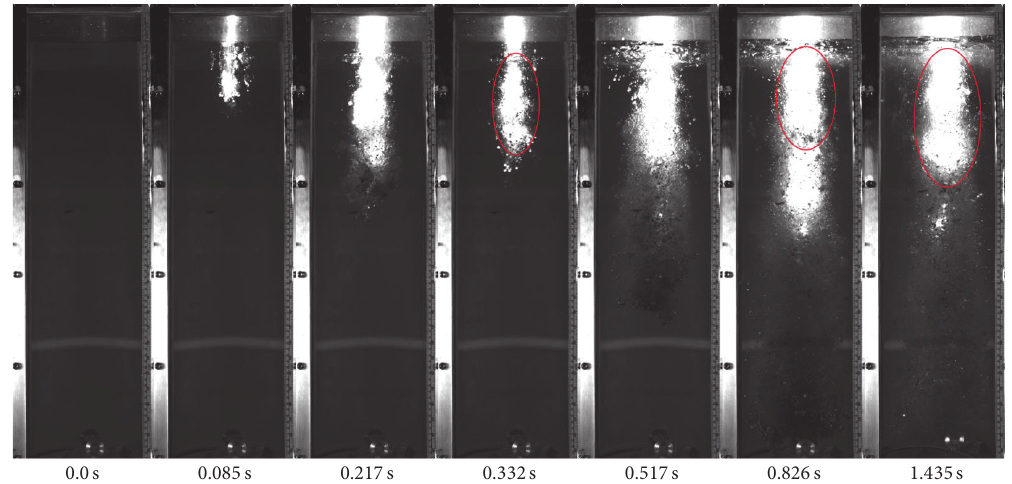
Figure 3: Melt permeating process of test